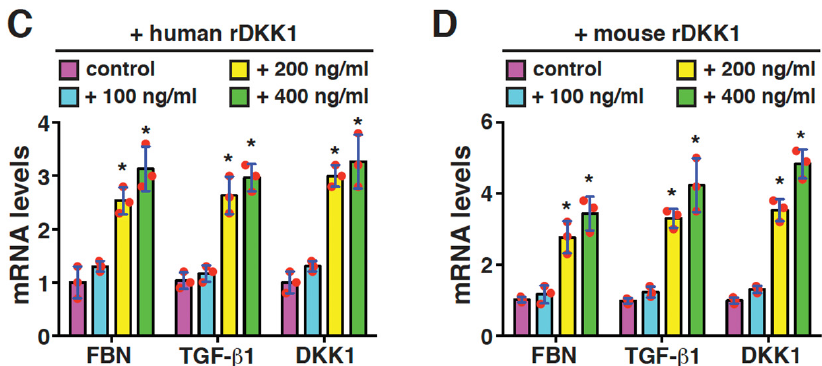
Figure 6. DKK1 acts as a profibrotic mediator in mouse mesangial cells. ( A ) Effects of increasing amounts of recombinant human DKK1 (100, 200 and 400 ng/mL) on the expression of FBN, COL- IV, TGF- β 1, α -SMA, DKK1 and β -catenin in mouse mesangial cells. The quantitative results from Western blots are plotted as mean ± SD (n = 3). * p < 0.05 versus the untreated control. ( B ) Effects of increasing amounts of recombinant mouse DKK1 (100, 200 and 400 ng/mL) on the expression of the indicated proteins in mouse mesangial cells. The quantitative data from Western blots are plotted as mean ± SD (n = 3). * p < 0.05 versus the untreated control. ( C ) Quantitative RT-PCR analysis of FBN, TGF- β 1 and DKK1 mRNAs expressed in mouse mesangial cells that were left untreated or treated with increasing amounts of recombinant human DKK1 (100, 200 and 400 ng/mL). * p < 0.05 versus the untreated control (n = 3). ( D ) Quantitative RT-PCR analysis of FBN, TGF- β 1 and DKK1 mRNAs expressed in mouse mesangial cells that were left untreated or treated with increasing amounts of recombinant mouse DKK1 (100, 200 and 400 ng/mL). * p < 0.05 versus the untreated control (n =